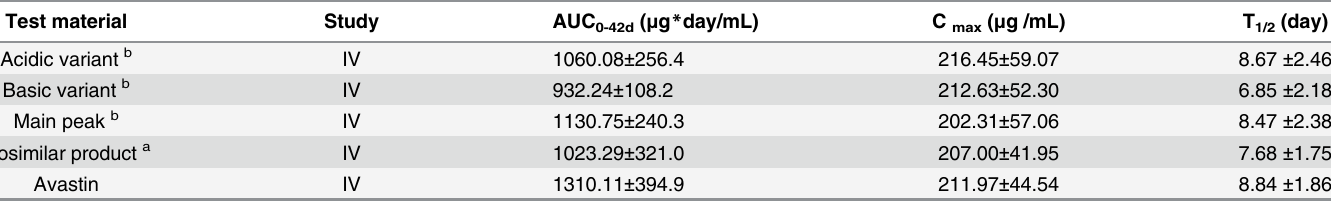
Table 3. Serum pharmacokinetics parameters for the isolated charge variants, the biosimilar product and Avastin after a single intravenous injec- tion of 10 mg/kg body weight in rats (n = 4, mean ± standard deviation). Test